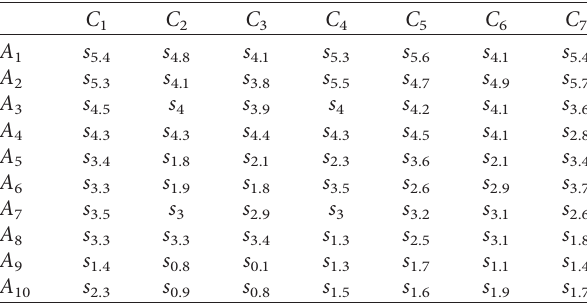
Table 5: The probabilistic linguistic score matrix of judgment debtors.